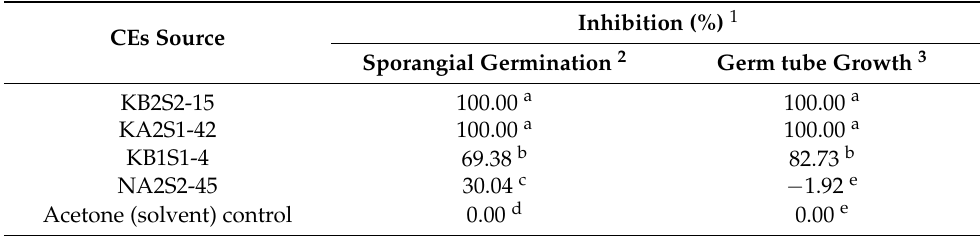
Table 3. Effect of crude extracts from the endophytes on sporangial germination and germ tube elongation of P. infestans.